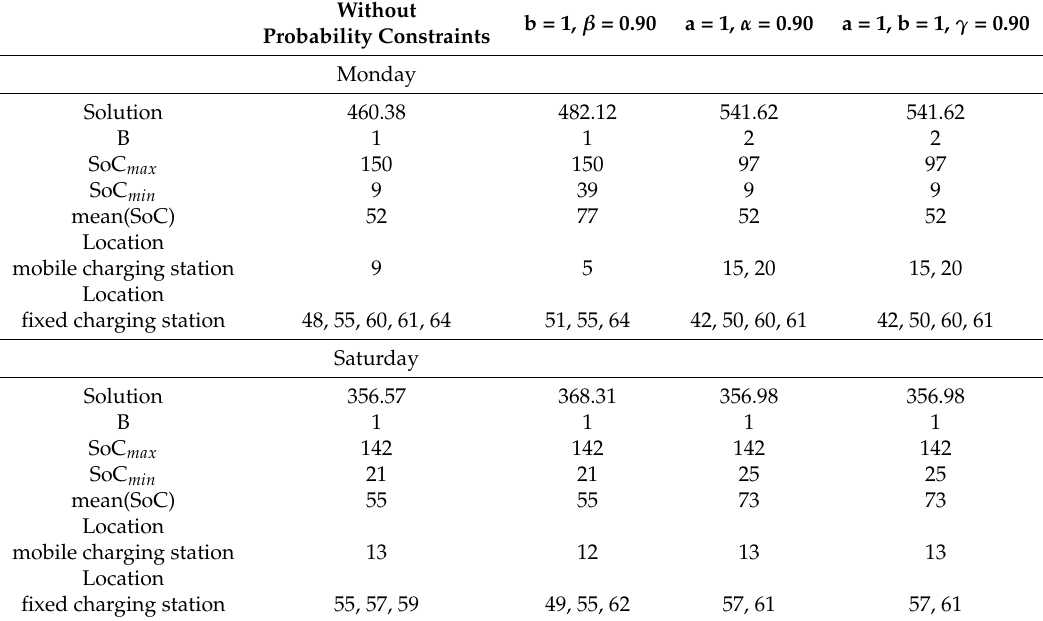
Table 4. Results for different days for ω U = 150 and 12:00–15:00 time period. Without b = 1, β = 0.90 a = 1, α =